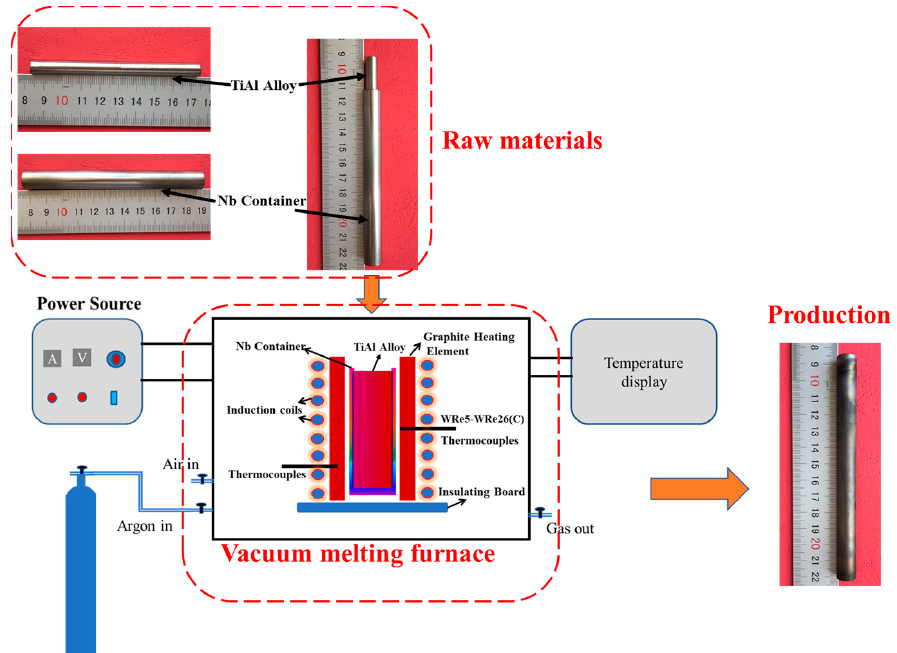
Figure 1. Sketch of experimental apparatus [52] (with the permission from Ref.[52]).